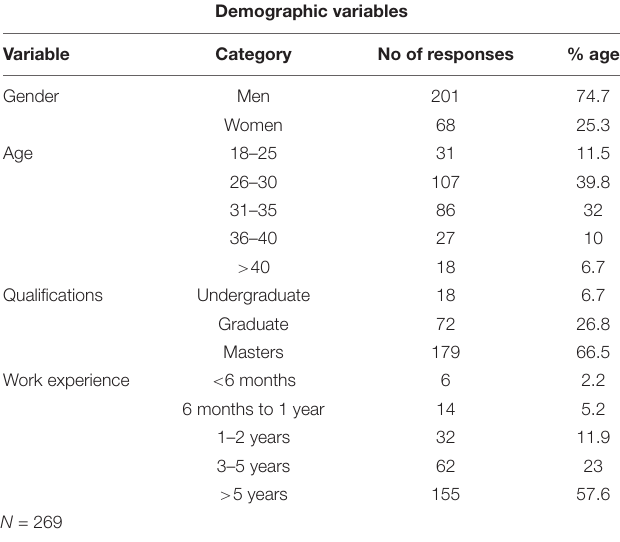
TABLE 1 | Respondent profile.